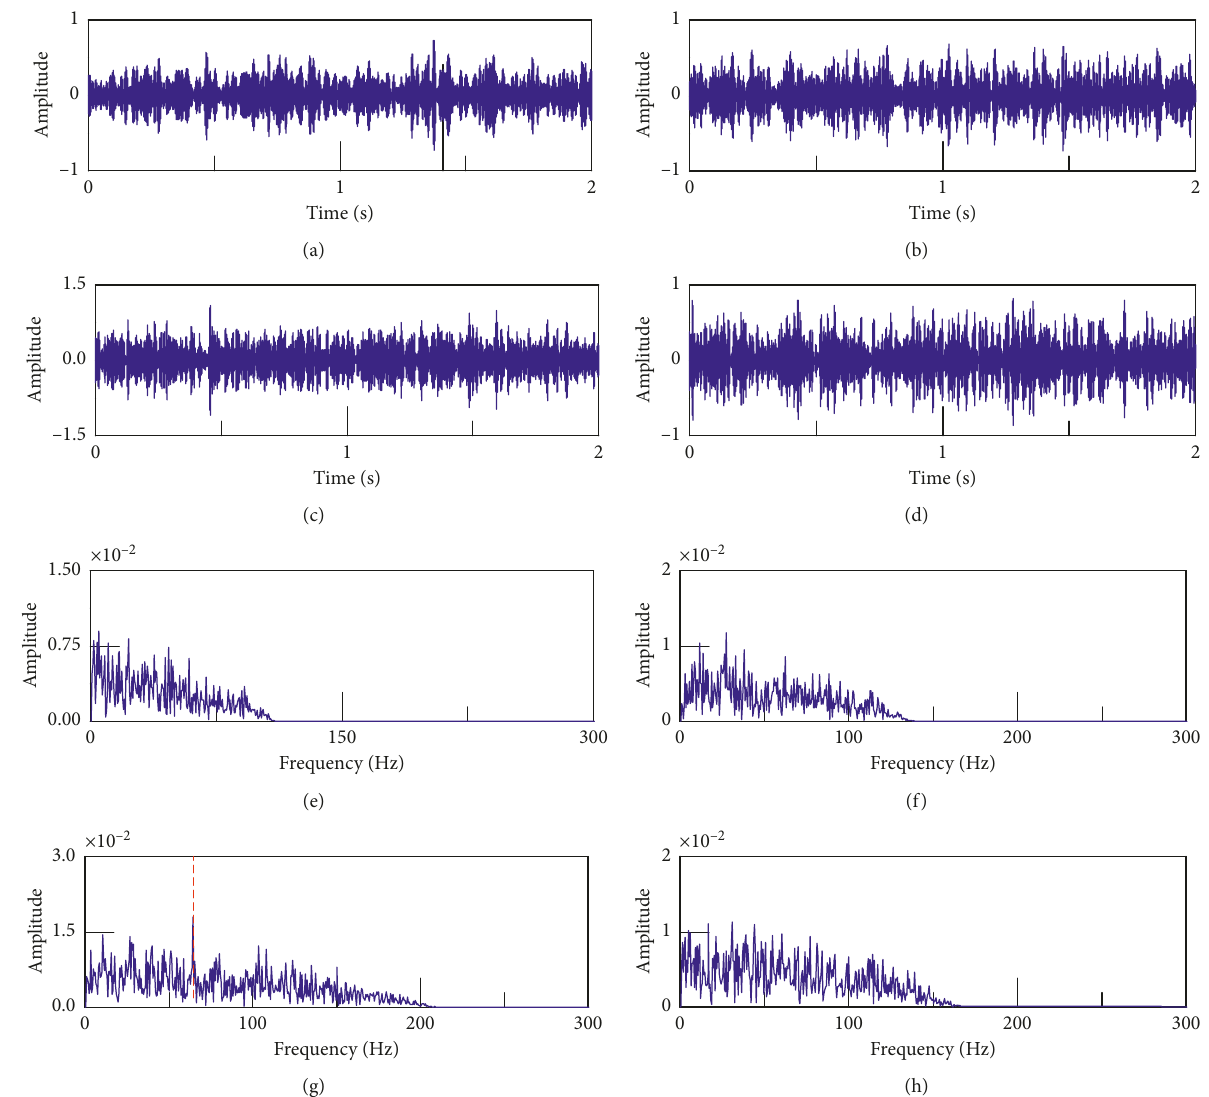
Figure 12: Results obtained by the traditional EWT and SSR: (a–d) sub-band signals; (e–h) squared envelope spectra (red dashed line: characteristic fault frequency 1/ T p